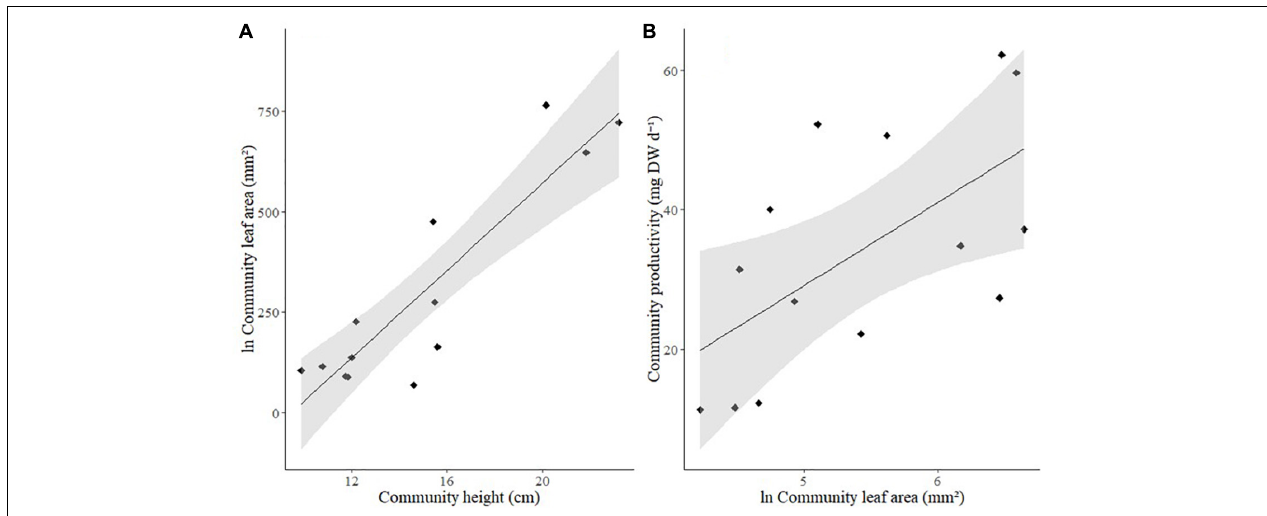
FIGURE 4 | Relationship between (A) Community height (cm) and community leaf area (ln-transformed, mm 2 ), (B) Community leaf area (ln-transformed, mm 2 ) and community productivity (mg DW d − 1 ). Solid line: line of best fit, shaded area: 95% confidence